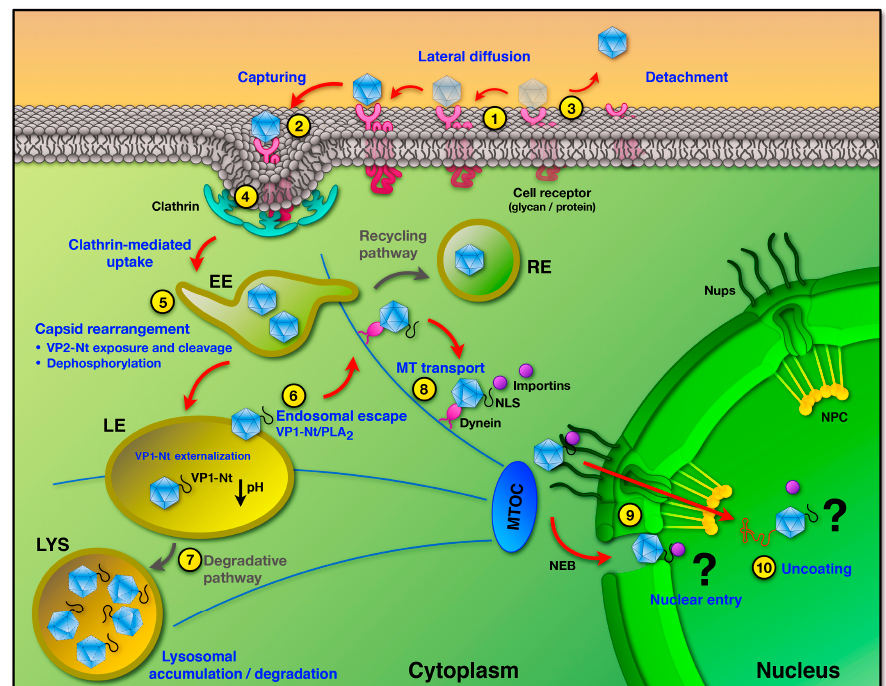
Figure 4. Model of PtPV cell entry and nuclear import. In the productive infection, PtPV capsids bind to one or more cell receptors (1). Following lateral diffusion, capsids are captured by pre-formed or forming clathrin pits (2). Or otherwise become detached from their receptors (3). Capsids are internalized via clathrin-mediated endocytosis (4) and enter the endocytic pathway where the low pH environment and local enzymes trigger structural rearrangements (5). Major structural changes are de novo VP2-Nt exposure and cleavage and particle dephosphorylation, leading to VP1-Nt (or VP1uR) exposure through the channel. The endosomal trafficking may vary in complexity and time, but commonly only a small proportion of particles escape after altering the endosomal membrane through the activity of the VP1-encoded phospholipase A2 (6). Many incoming infectious particles fail to escape from endosomes and are routed to and accumulated in the degradative lysosomes (7). In the cytosol, PtPV exploit the cytoskeleton and motor proteins to move to the nuclear vicinity (8). It is not yet clear how the viruses and/or their genomes enter the nucleus, as nuclear pore-dependent entry and permeabilization of the nuclear envelope have been proposed (9). The site and timing of capsid uncoating are also uncertain processes. Growing evidences suggest that capsids remain assembled in the cytosol and enter the nucleus intact, and the uncoating would take place during the interaction with NPC proteins and/or following nuclear entry